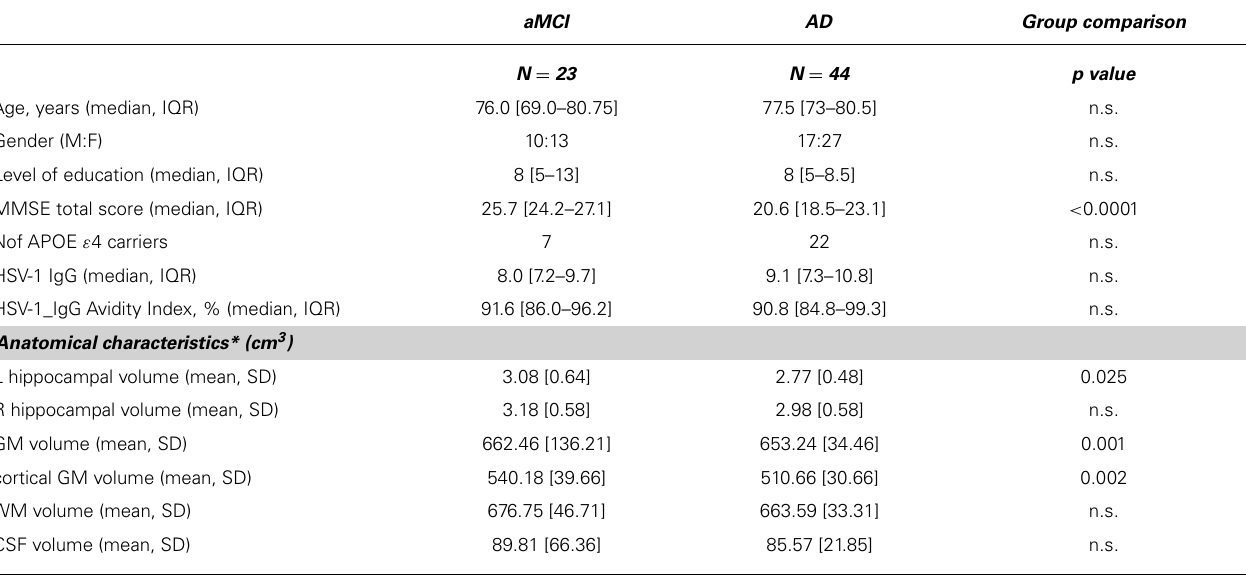
Table 2 | Demographical, neuropsychological, immunological, and anatomical information of the MRI subsample. aMCI